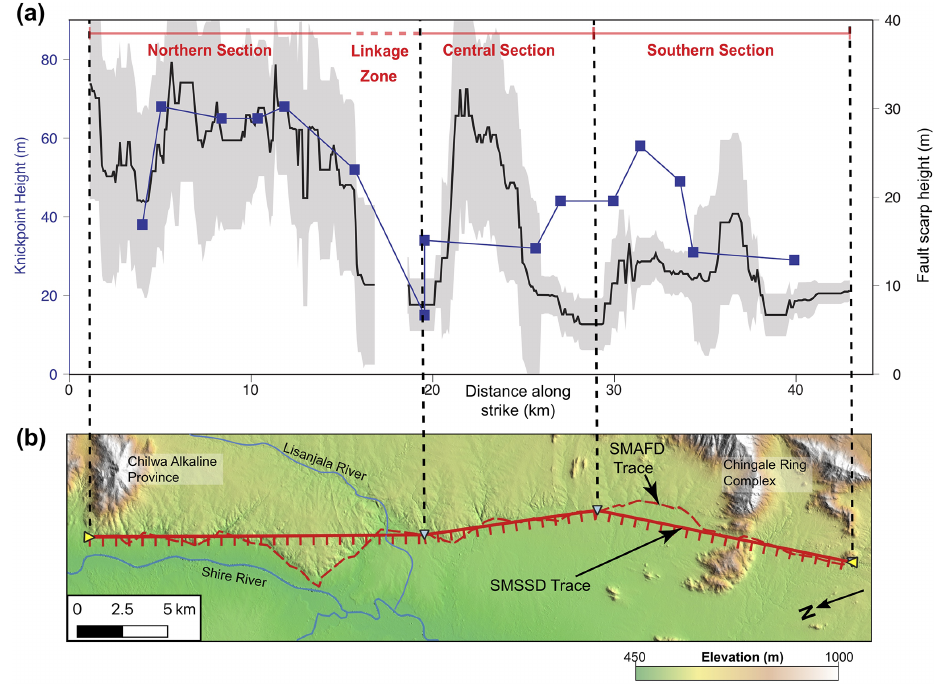
Figure 4. Fault segmentation along the Chingale Step fault, modified after Wedmore et al. (2020a). (a) Along-strike variation in stream knickpoint (blue points) and fault scarp height (black line), with the gap due to erosion by the Lisanjala River. Grey shading represents 1 standard deviation error in scarp height measurements (Wedmore et al., 2020a). (b) A map of the Chingale Step fault underlain by TanDEM- X DEM, with the extent of the area shown in Fig. 2b. The dashed red line shows the surface trace of the fault as per the South Malawi Active Fault Database (SMAFD). The solid red line shows the simplified geometry of the fault in the South Malawi Seismogenic Source Database (SMSSD), where it is defined by straight lines between section end points (blue triangles). Ticks indicate fault hanging wall. An along-strike scarp height minima at the boundary between the northern and central section occurs at a bend in the fault scarp; however, there is no obvious geometrical complexity at the along-strike scarp height minima between the southern and central sections. Topography associated with the Proterozoic Chingale Ring Structure and Chilwa Alkaline Province (Bloomfield, 1965; Manda et al., 2019) is also indicated. For full details on panel (a) , see Wedmore et al.